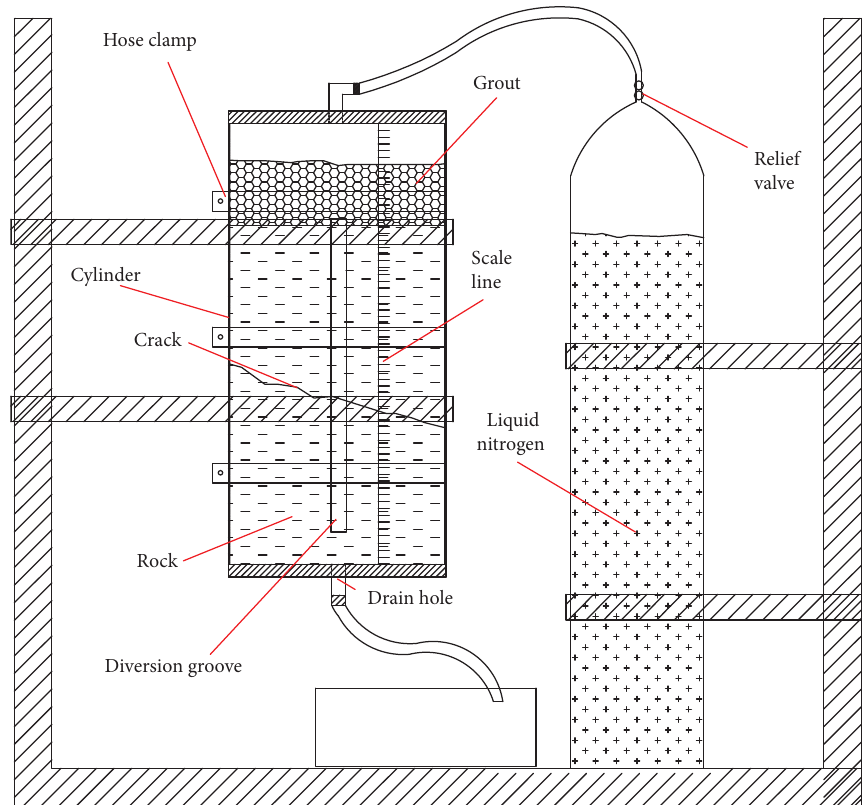
Figure 3: Schematic diagram of the self-designed grouting repair